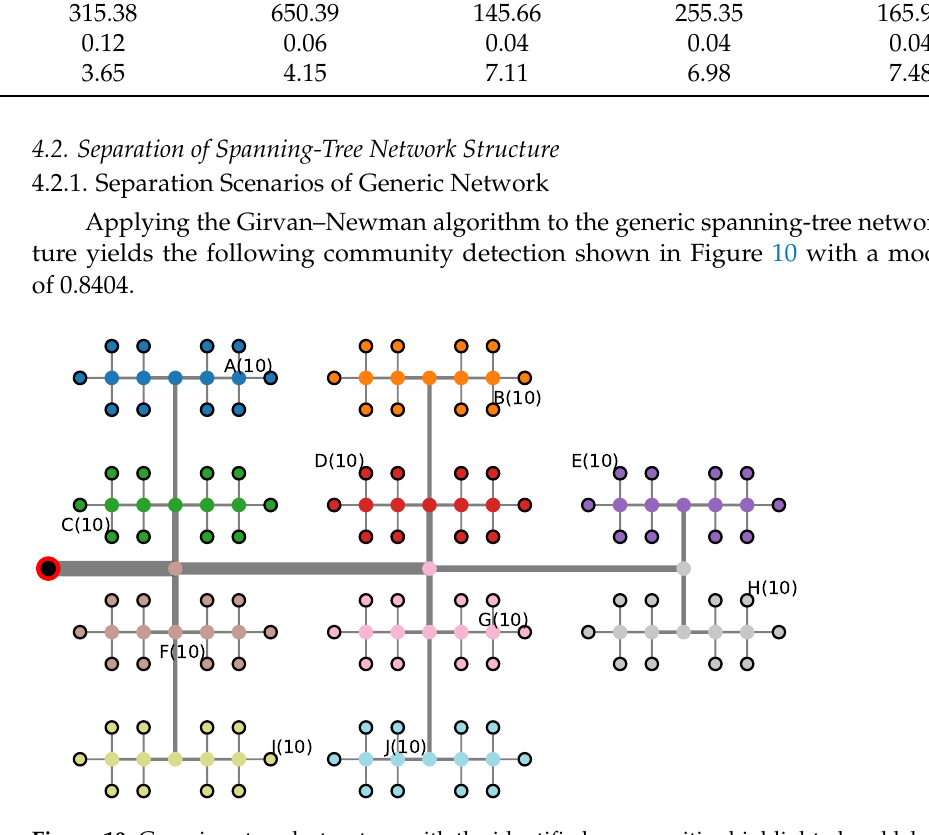
Figure 10. Generic network structure with the identified communities highlighted and labelled; the corresponding number of included buildings is indicated in parentheses